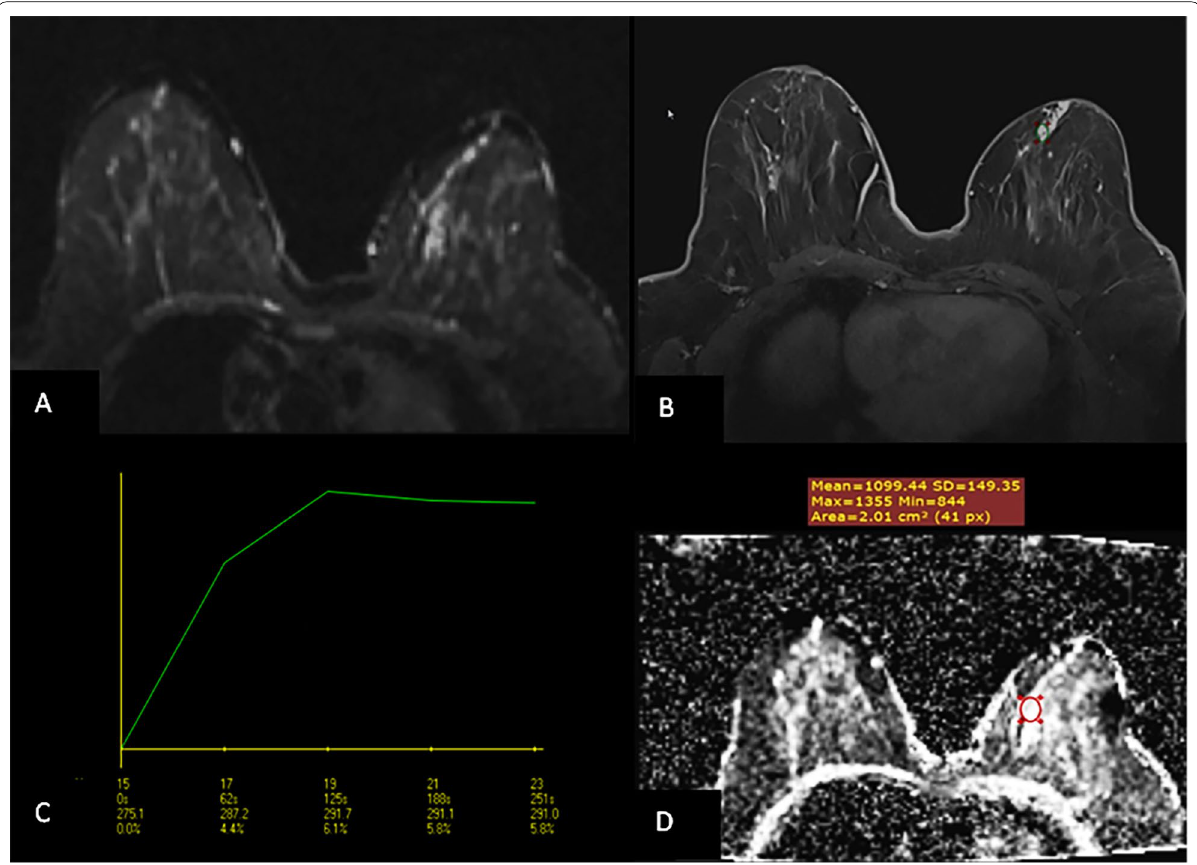
Fig. 3 Case 2: A 52‑year‑old female patient presented with left Breast UIQ asymmetry warranting further investigation (not illustrated on images). DCE‑MRI: STIR ( A ), post‑contrast dynamic sequences ( B ) with time–intensity curves ( C ), and ADC mapping ( D ) revealed Left breast UIQ non‑mass enhancement extending to the retro‑areolar region showing type II (plateau curve) on plotting time–intensity curve ( C ) and facilitated diffusion with ADC value of 1.35 ( D ). Ultrasound‑guided VAB‑assisted biopsy histopathological results revealed intraductal papilloma UDH and focal sclerosing adenosis with no malignant cells. MDT advised